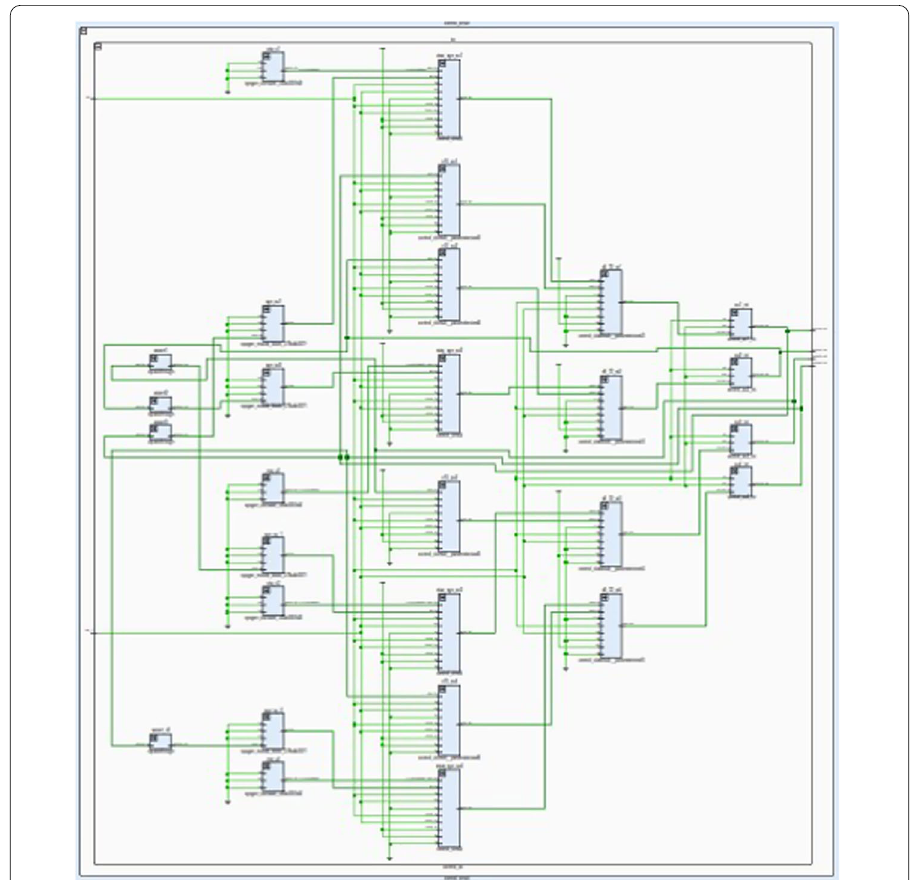
Figure 17 Xilinx RTL schematics of the Sliding surfaces with fractional integrators.